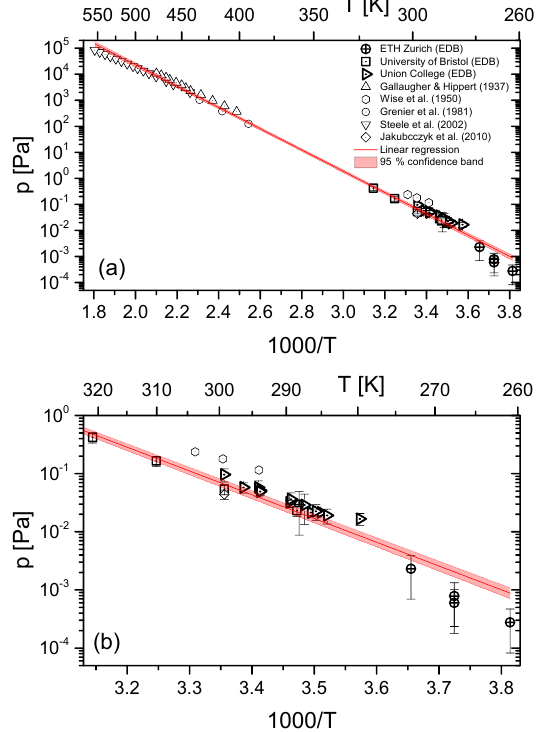
Figure 2. Saturation vapor pressures vs. temperature of triethylene glycol (PEG3). Bold open symbols: this work; open symbols: data reported in the literature. Red line: linear regression to all data be- low 500K; red shaded area: 95% confidence band of the regression. (a) Overview of all data, (b) cut-out showing the pressure range of the experimental data of this